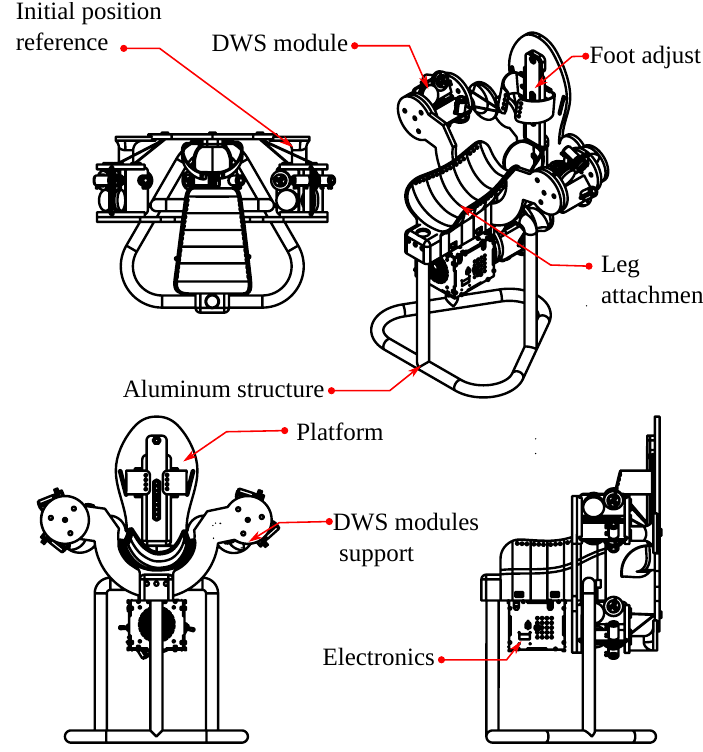
Figure 22. Complete